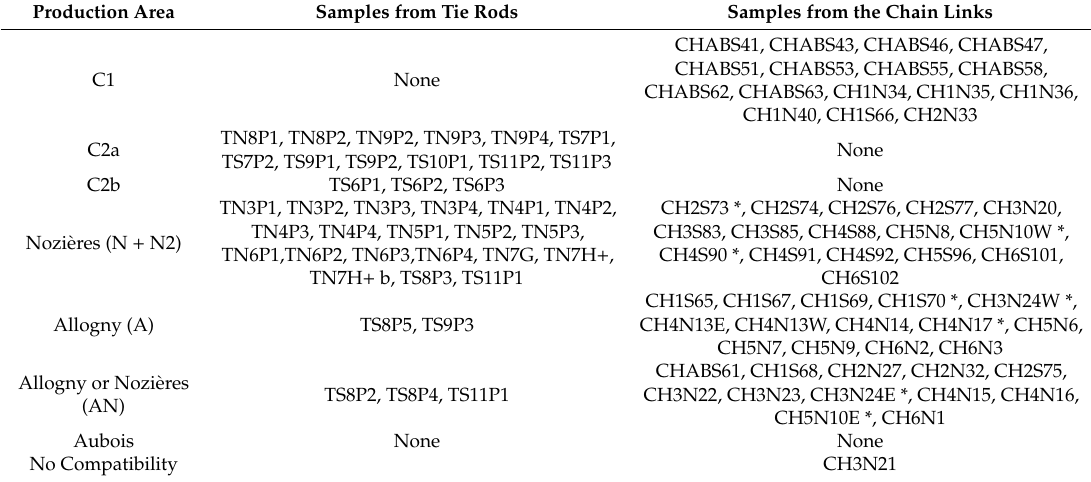
Table 6. Summary of provenances determined on the iron samples from Bourges Cathedral, (* indicates recycled samples characterized by metallographic and elemental